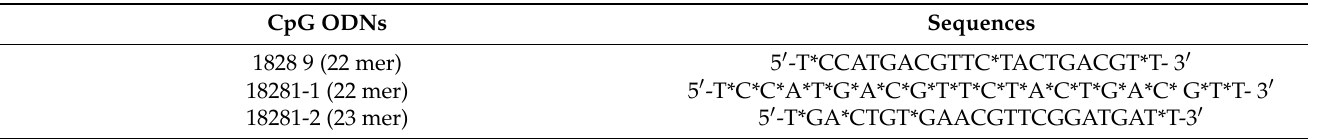
Table 1. Types of cytosine phosphoguanine oligodeoxynucleotides (CpG ODNs) used in the study. CpG ODNs Sequences 1828 9 (22